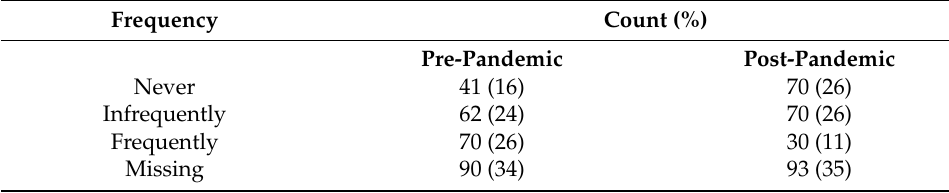
Table 4. Frequency of accessing Indigenous cultural